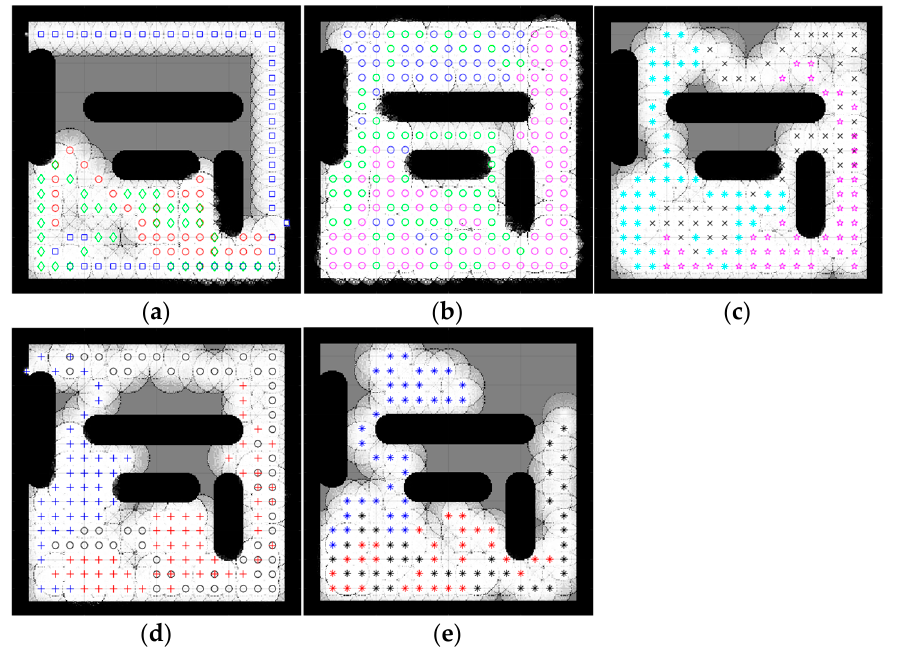
Figure 10. Percentage of the explored area after implementing the CME-SSA and the other approaches on complex map 4. Complex map 4: ( a ) CME, 69.45% (Iteration 50); ( b ) CME-SSA, 97.25%; ( c ) CME-GWO, 86.57%; ( d ) CME-GWOSSA, 81.44%; ( e ) CME-SCA, 79.12%.